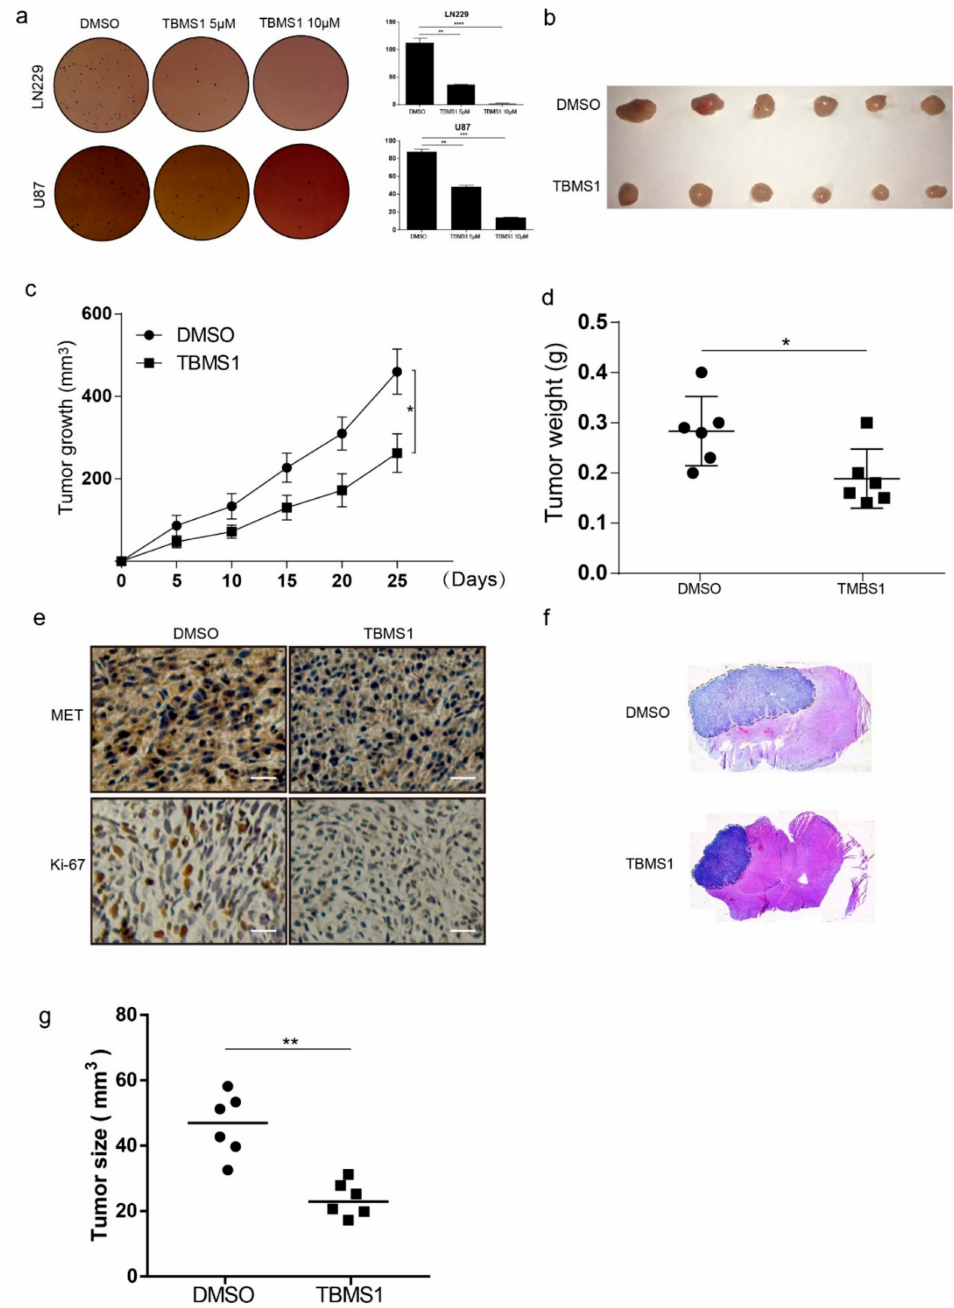
Figure 5. TBMS1 inhibits glioblastoma cells clonogenicity and tumorigenesis and the expression of MET. ( a ) The clonogenicity of LN229 and U87 treated di ff erent concentrations of TBMS1. On the left is the formation of clones after 3 weeks of culture, and on the right is a statistical plot of the number of clones formed. DMSO was added as a control. ( b ) After subcutaneous injection of U87 cells into mice, subcutaneous tumors obtained by injecting TBMS1 and DMSO for 25 days, respectively. ( c ) A graph of tumor growth in mice during dosing. ( d ) Subcutaneous tumor weight statistics after 25 days of mice administration. ( e ) Immunohistochemistry experiments were used to detect the expression levels of MET and Ki-67 in mouse tumor tissues. Scale bar = 200 µ M. ( f ) After intracranial injection of U87 cells into mice, intracranial tumors obtained by injecting TBMS1 and DMSO for 23 days, respectively. ( g ) Size statistics of intracranial tumors. * p < 0.05, ** p < 0.01, *** p < 0.001, p -values < 0.05 were considered as statistically